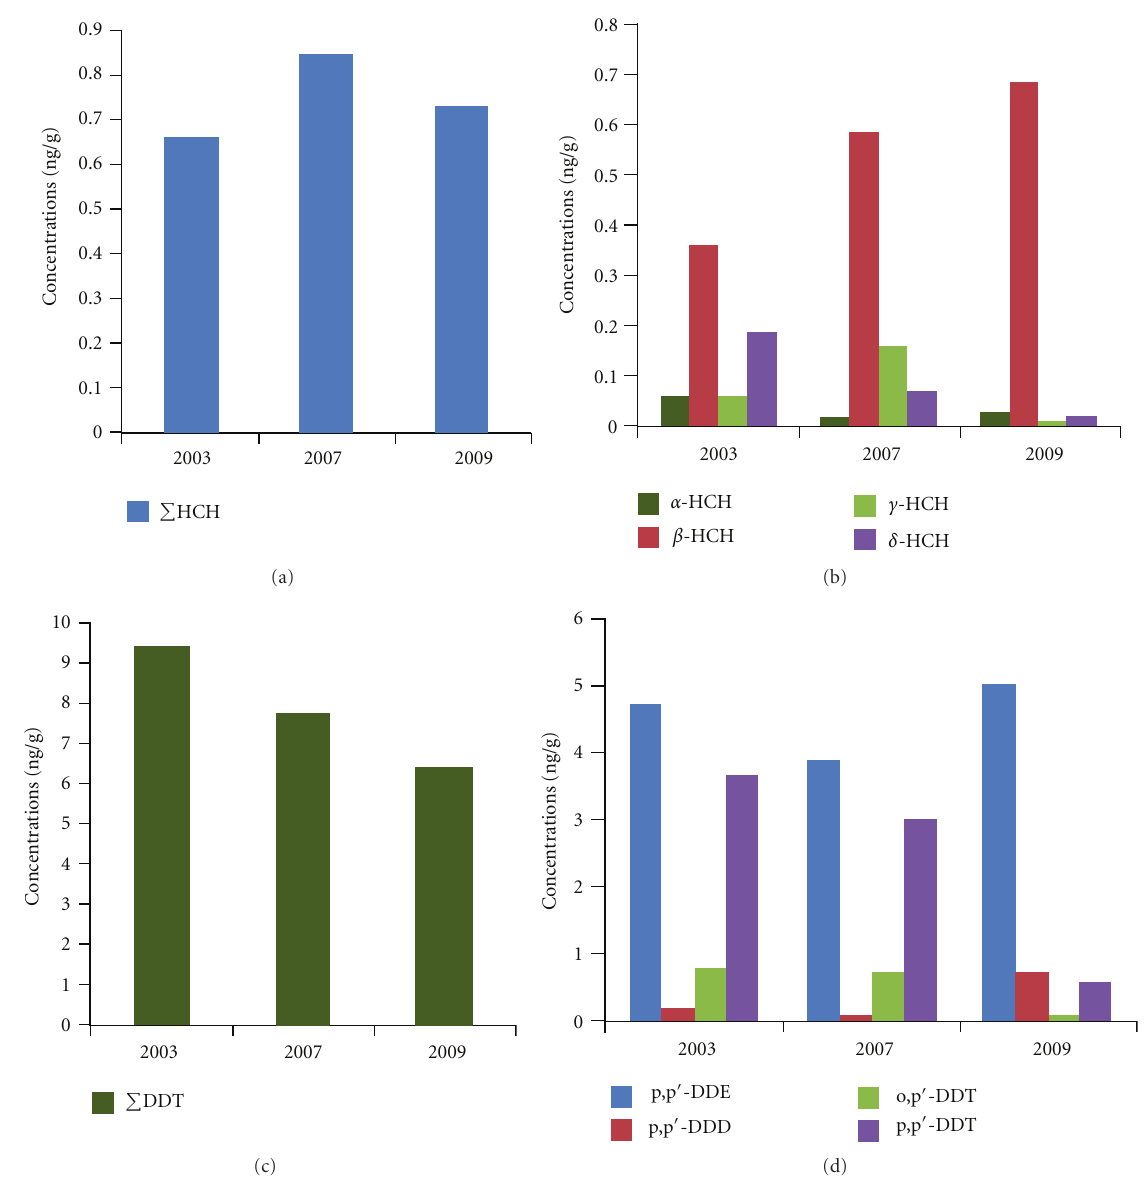
Figure 2: Temporal trends of HCHs and DDTs in soils from 2003 to